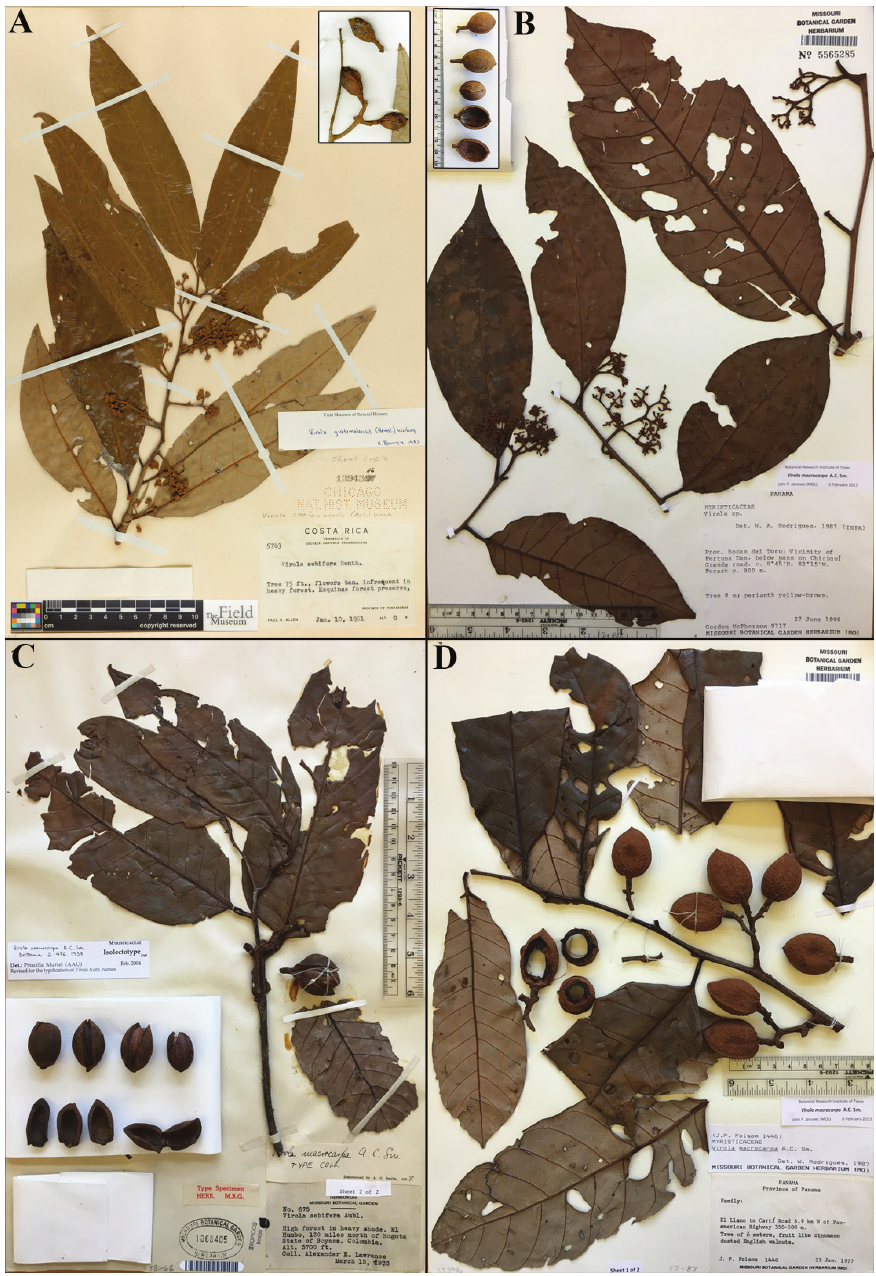
Figure 7. Comparisons of Virola macrocarpa with similar species in Mesoamerica A V. allenii ( P. H. Allen 5763, F; inset fruits, from P. H. Allen 6727, GH) B V. amistadensis ( G. McPherson 9717 , MO; inset fruits, from G. McPherson 9715 , MO) C V. macrocarpa ( A. E. Lawrance 675 , MO) D V. otobifolia ( J. P. Folsom 1440 , MO). Image courtesy of Field Museum ( A